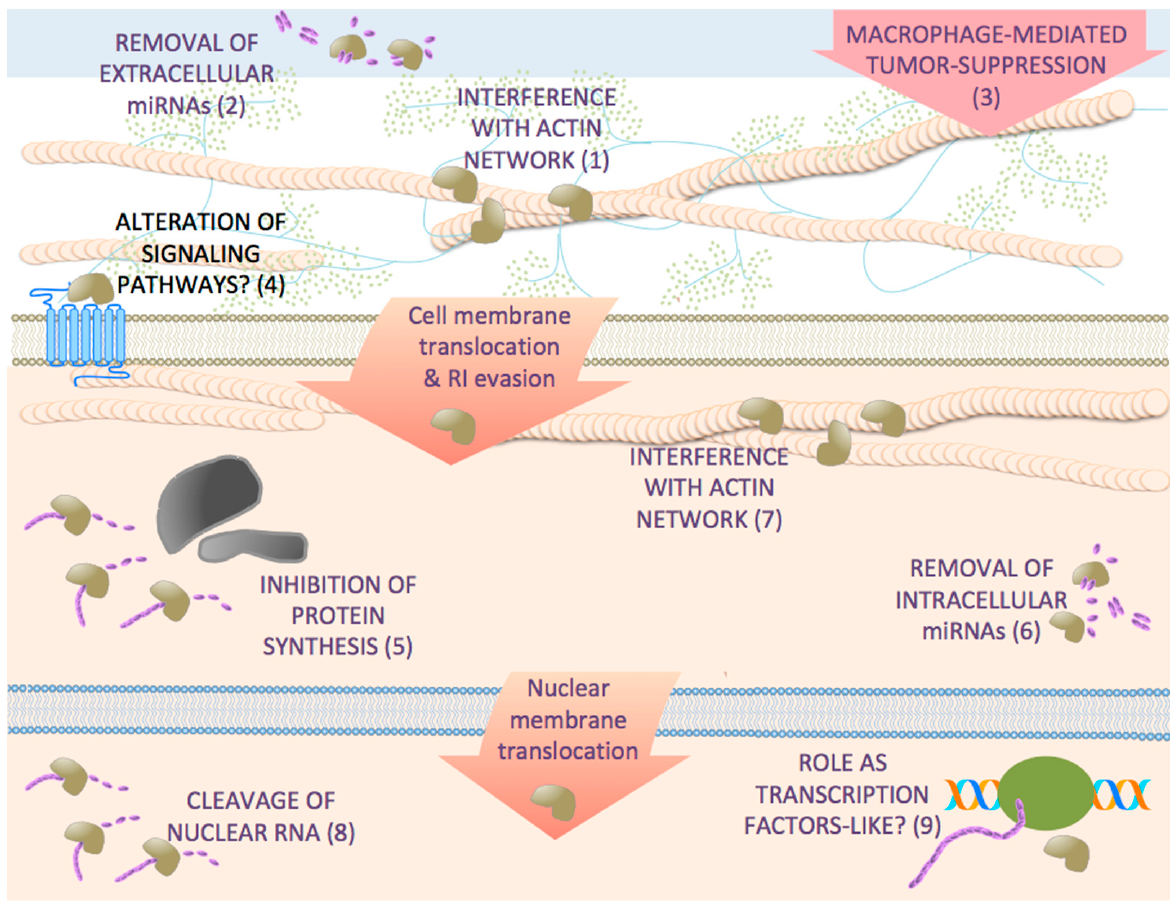
Figure 1. Mechanisms of the cytotoxic action of secretory RNases. Different RNases act in the extracellular space, in the cytosol and even in the nucleus. On the extracellular space, RNases like RNASET2 interfere with the organization of extracellular actin network, inhibiting cell motility and invasiveness (1). In other cases, they decrease the circulating miRNAs attenuating in part the tumor malignancy (2). It is also hypothesized that some of them, like RNASET2, could be a regulator of several functional features within the immune system inducing the macrophage mediated tumor suppression (3). They may also potentially function as ligands for different cell receptors that can or cannot drive their internalization or affect signal transduction pathways (4). Some of the RNases can translocate into the cytosol and evade the RI. There, some of them are able to inhibit protein synthesis by cleaving rRNA, tRNA, or mRNA (5). It is demonstrated that some RNases, like ONC, also can cleave miRNAs and precursors (6). RNases like ACTIBIND T2 disrupt intracellular actin filament and actin-rich extracellular extrusion organization inhibiting cell migration (7). Finally, some RNases reach the nucleus where they can cleave nuclear RNA (8) or potentially function as transcription factors-like (9). Because of all these activities, the RNases alter the pool of cytosolic and nuclear coding and non-coding RNAs inducing cell death.